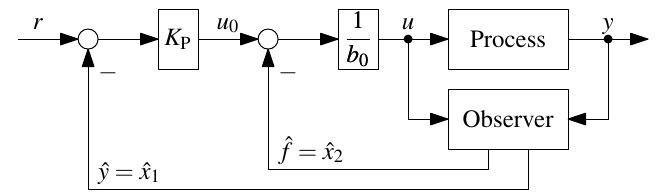
Figure 1. Control loop structure with ADRC for a first-order